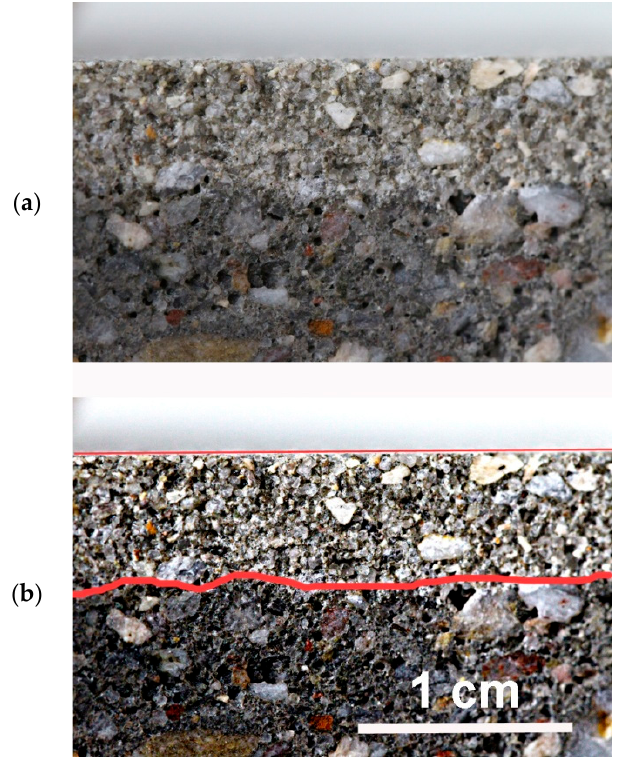
Figure 7. Results of penetration depth revealed by water spraying: raw photo ( a ) and photo after contrast adjusting ( b ). Table 4. The penetration depth of the silane into the concrete.